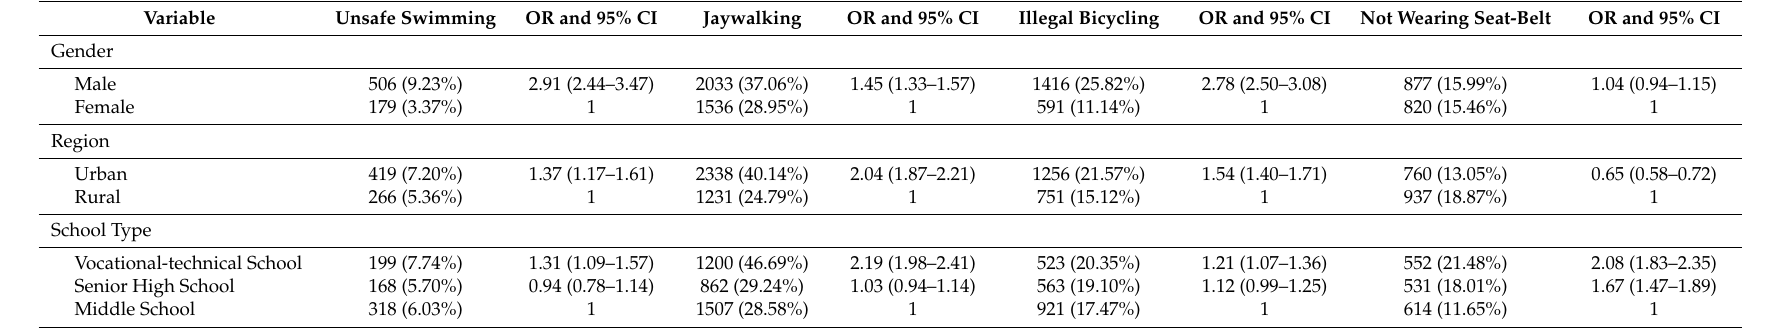
Table 2. Single behaviour characteristics of unintentional injury in the student population.